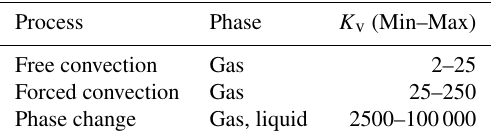
Table 1. Typical values of K v for different convection processes (Incropera and Dewitt,